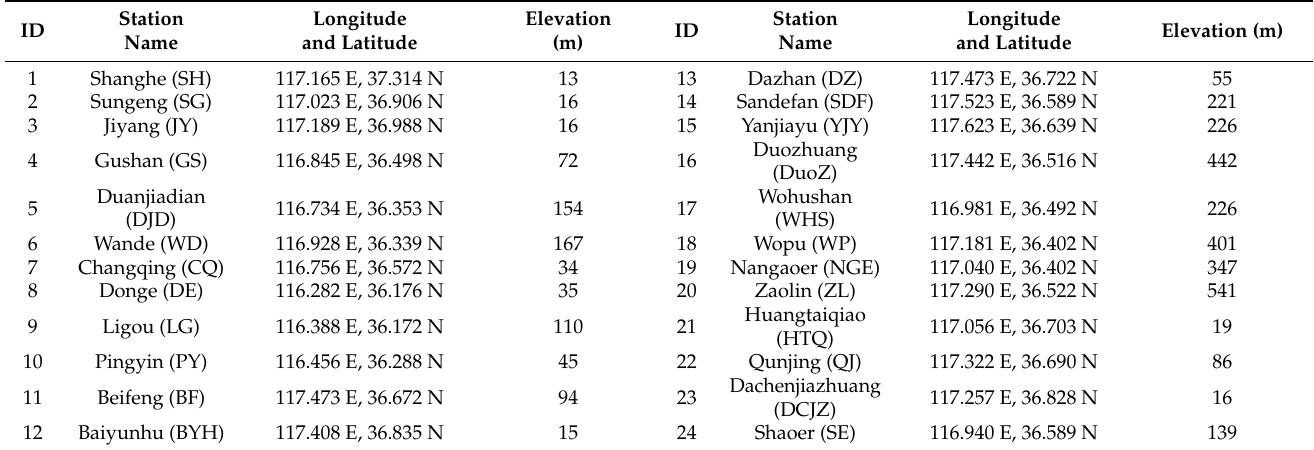
Table 1. Information on the 24 land observation stations in Jinan